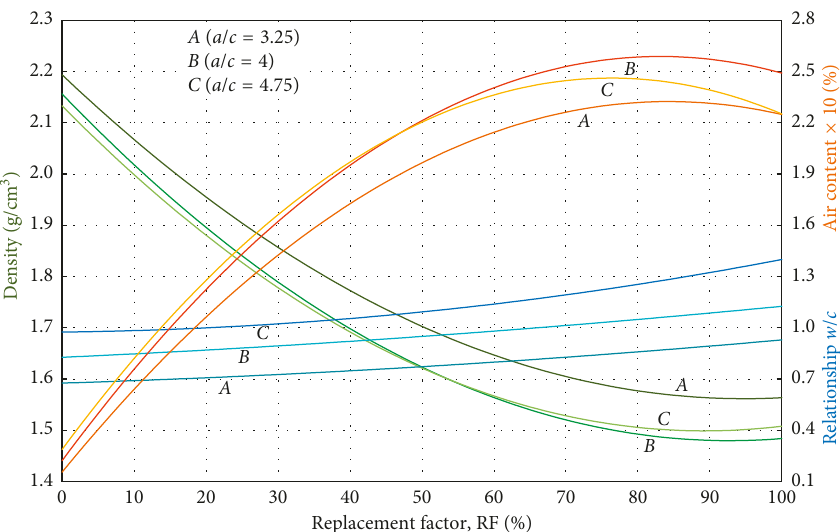
Figure 4: Triple interaction diagram of the fresh-state properties of the